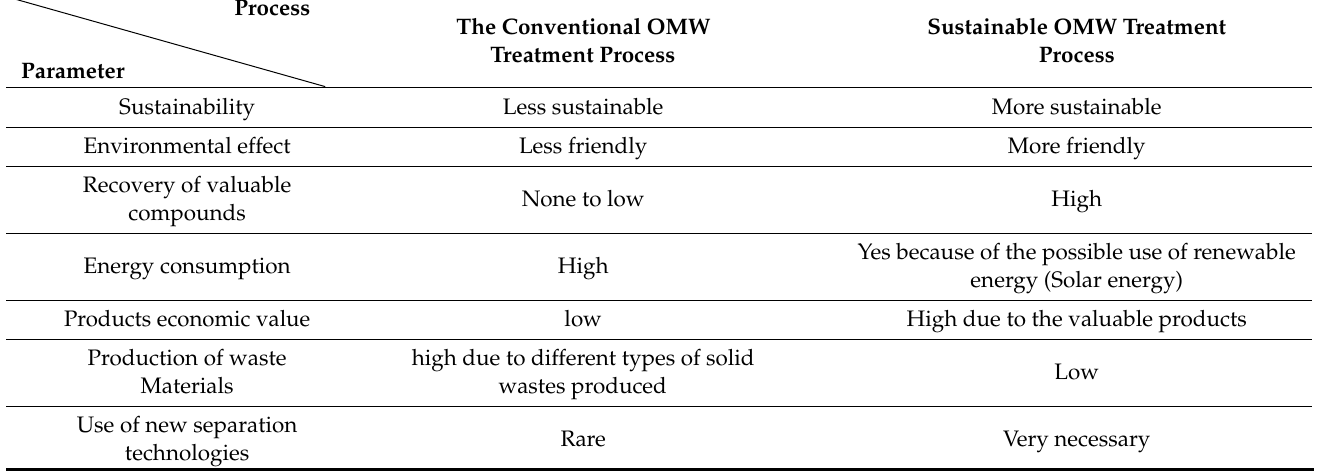
Table 13. Comparison between conventional and sustainable treatment processes applied for